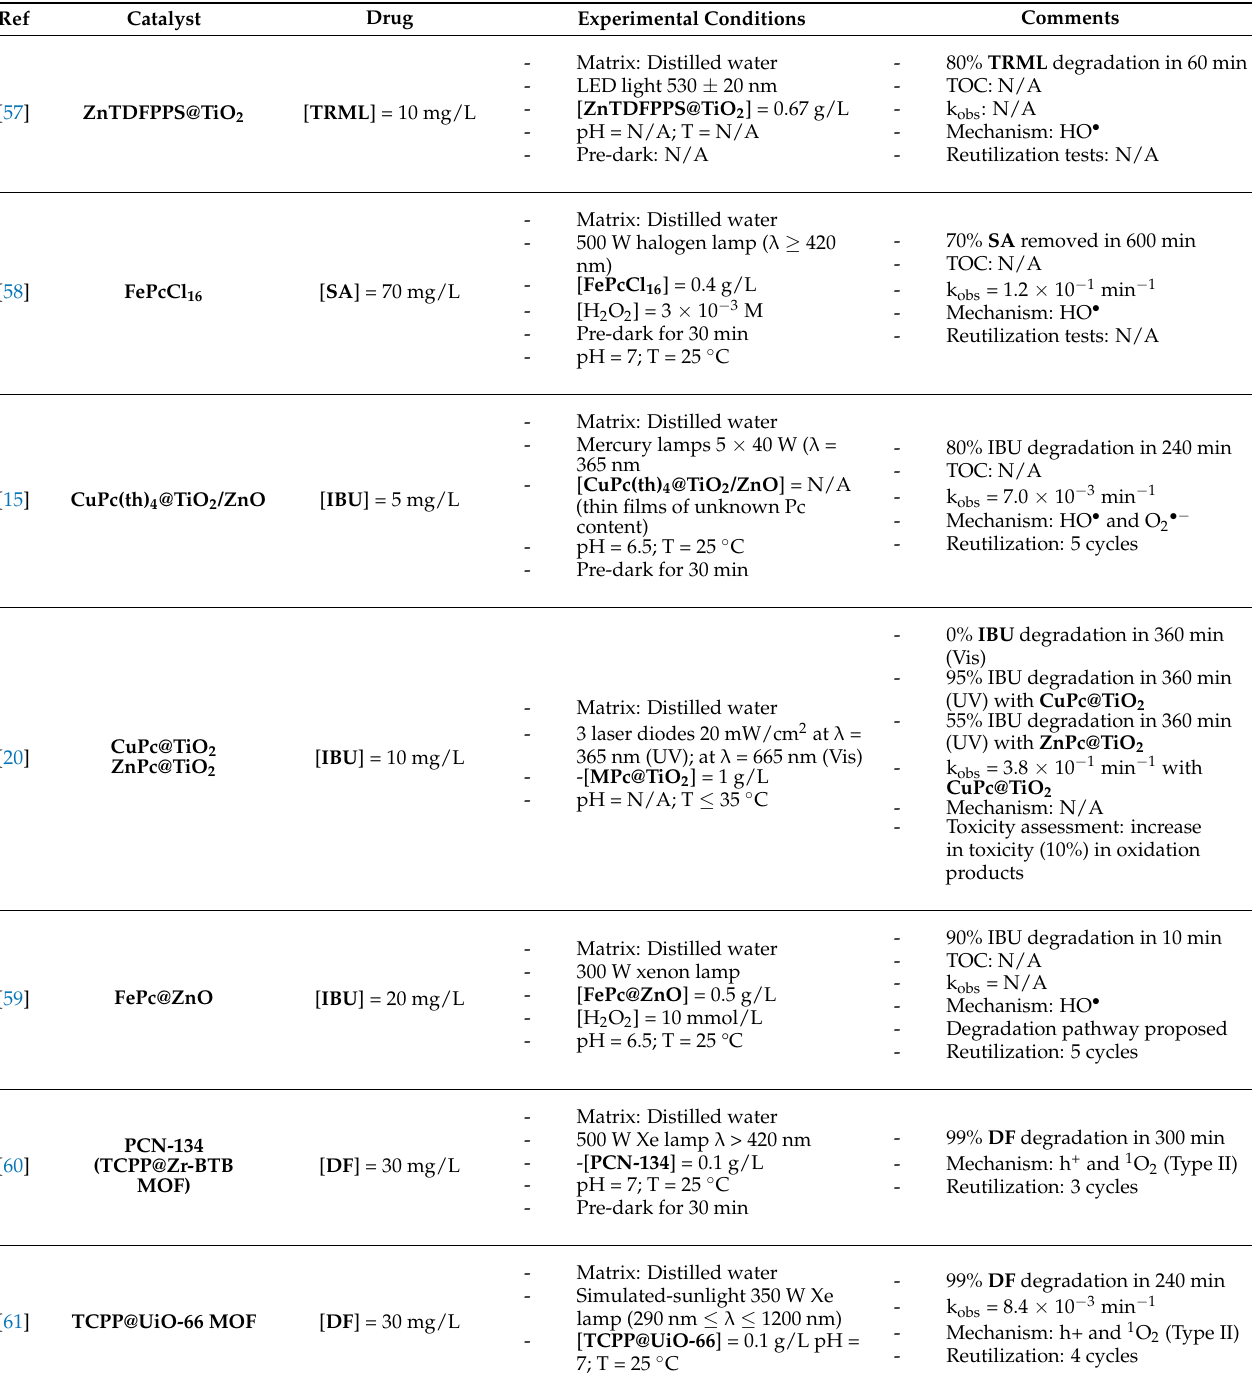
Table 3. Photochemical degradation of analgesic drugs using TPM-based